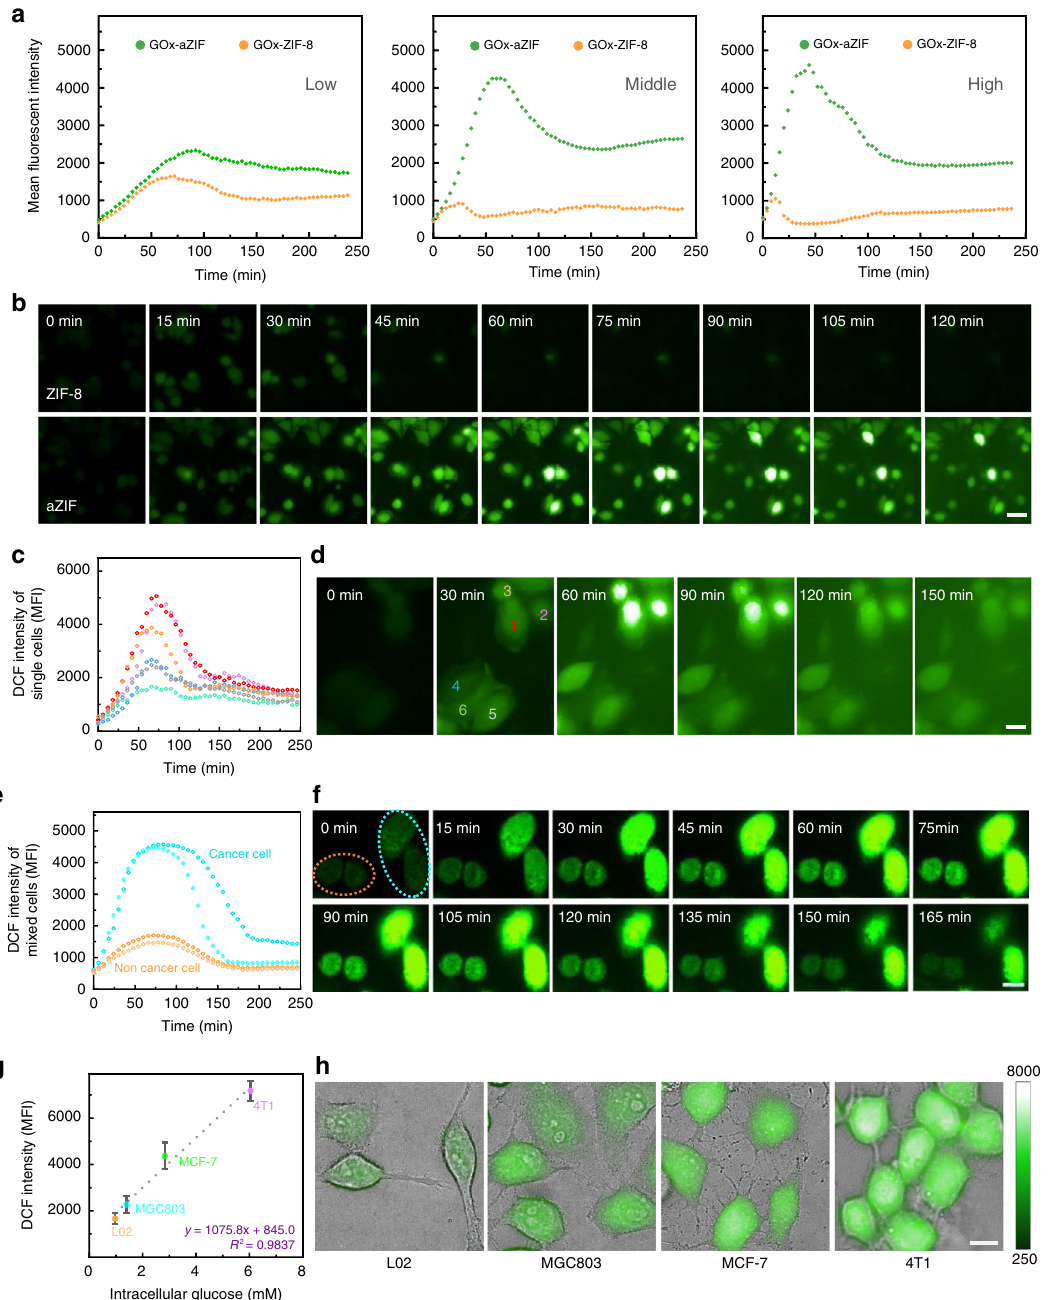
Fig. 3 Enzyme delivered into cancerous cells for in situ glucose detection. a The kinetics showing the fl uorescence intensity of DCFH-DA in MCF-7 cells after delivery of different amounts of GOx-aZIF and GOx-ZIF-8 (concentration of 4.5 μ g mL − 1 (Low), 15 μ g mL − 1 (Moderate), 45 μ g mL − 1 (High)). b DCFH- DA cell-staining images in MCF-7 in the presence of GOx-aZIF or GOx-ZIF-8 at moderate concentration of GOx. Scale bar, 30 μ m. c – h Applications of GOx-aZIF for glucose detection in single cells ( c , d ), mixed cell types ( e , f ), and different cell types ( g , h ). DCF intensity kinetics ( c , e ). Cell images showing fl uorescence changing with time ( d , f ). The orange and cyan ovals in ( f ) outline the normal and cancer cells, respectively. g Correlation between DCF intensity and intracellular glucose concentration. Data in the calibration plot were presented as mean ± s.d. n = 2 biologically independent samples (the images in duplicated samples with a total of ten different fi elds were captured and calculated). h Cell images at the peak intensity of different cell types. Scale bars in d , f , h , 10 μ m. Source data are provided as a Source Data fi and hydrogen peroxide (H 2 O 2 ), which can be identi fi ed by the the comparison of the intracellular activity of the two composites, elevated fl uorescence of a (cid:129) OH-sensitive fl uorescent dye (2 ′ ,7 ′ - GOx-aZIF and GOx-ZIF-8. From the kinetic results of fl uores- dichlorodihydro fl uorescein diacetate, DCFH-DA). Considering cence of DCF (Fig. 3a), a higher enzyme dosage resulted in a the acid degradation pathway for free GOx (Supplementary faster catalytic speed (represented by a bigger initial slope of the Figs. 46 and 47 and Supplementary Note 13), we concentrated on FI – time curve) and a considerable step forward for the maximum